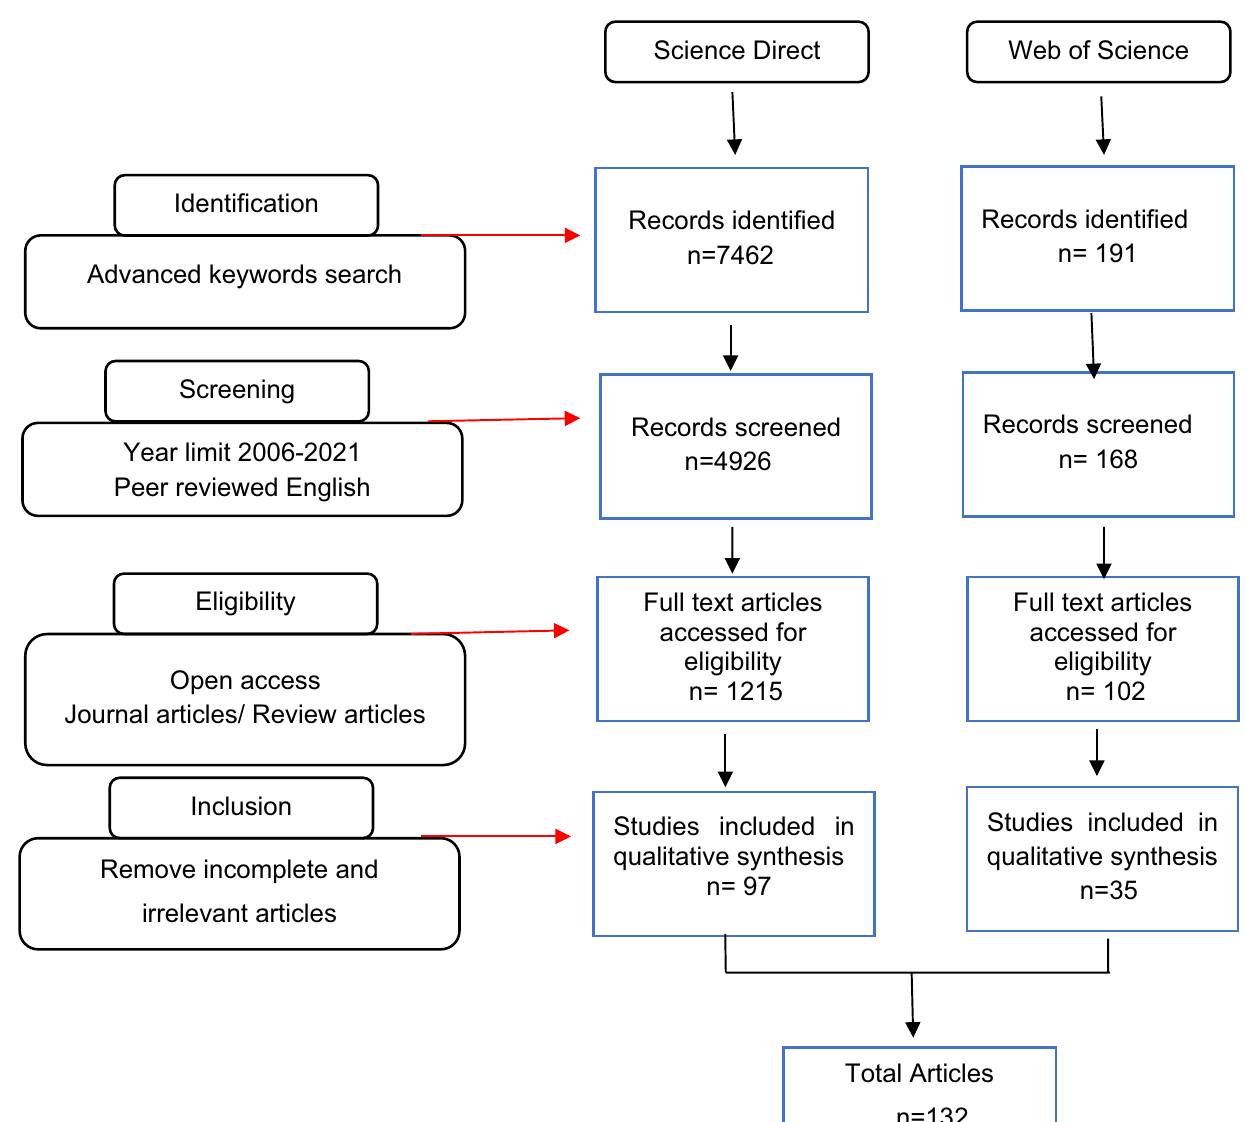
Fig. 1 Systematic article selection